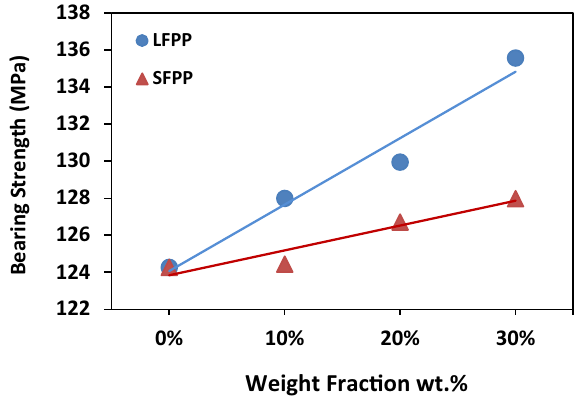
Figure 5. BSs of molded-in holes specimens with different weight fractions.